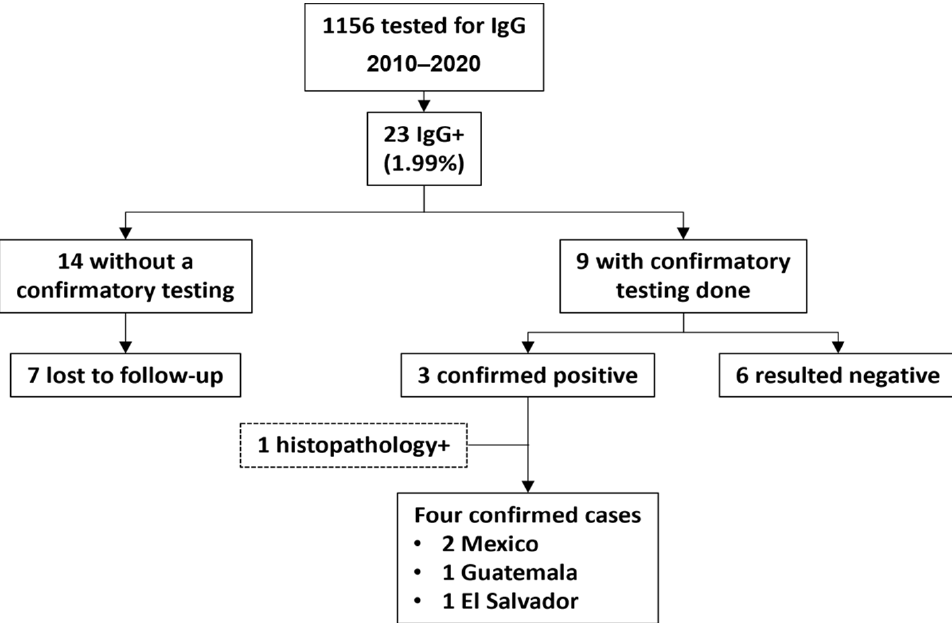
Figure 1. Detection and follow up of Chagas disease cases identified by serology at the University of Colorado Hospital from 2010 to 2020. Dotted frame: diagnosis established without serology testing.